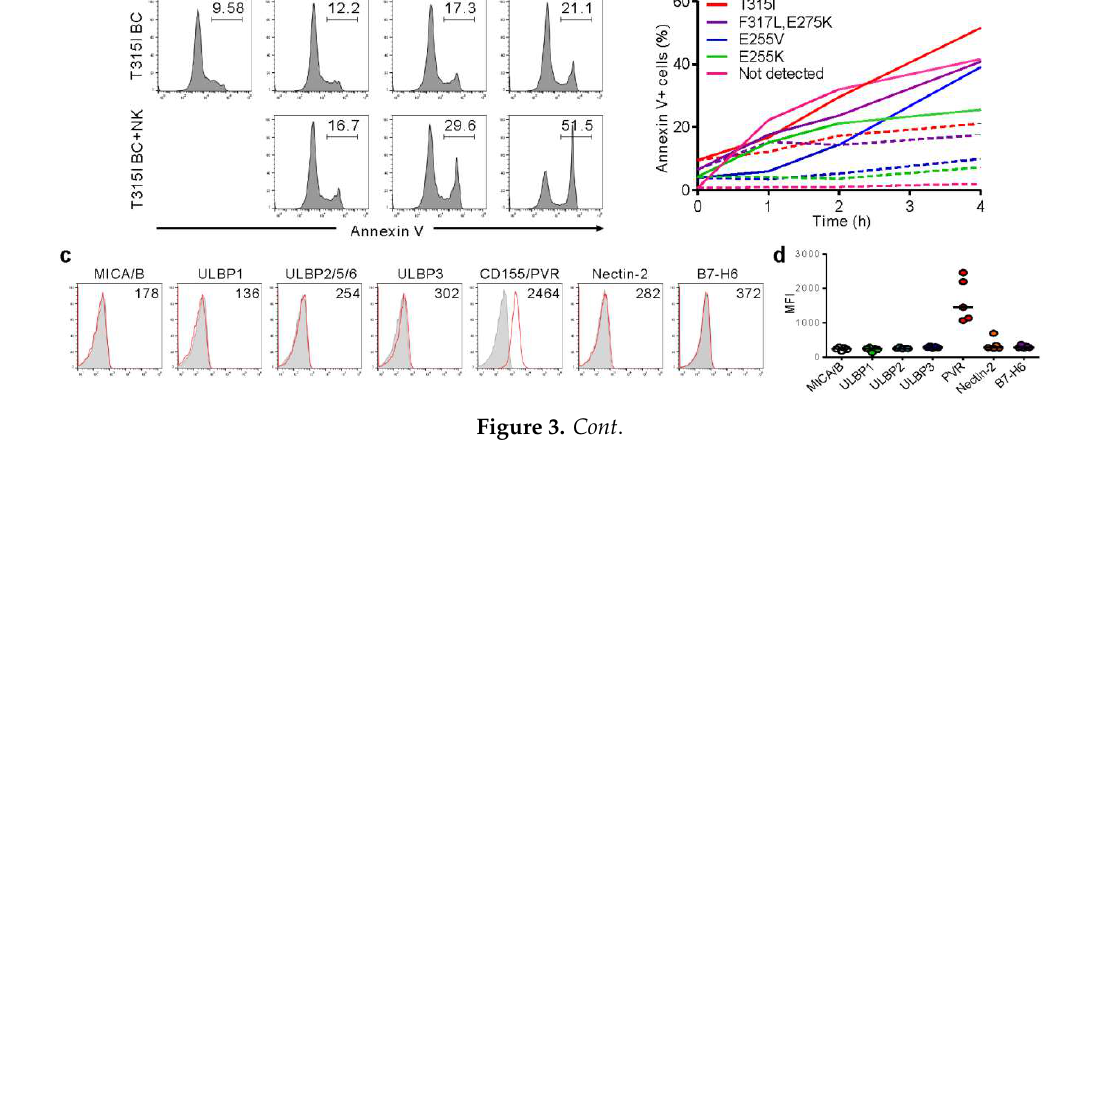
Figure 3. NK cells trigger cytolysis of primary CML-BC blasts, regardless of BCR-ABL1 mutation, in a DNAM-1-dependent manner. ( a ) Mononuclear cells (MNCs) from a CML-BC patient harboring BCR-ABL1 T315I were incubated with expanded primary NK cells for the indicated times. Apoptosis of CD34 + CML-BC cells in the absence or presence of NK cells in a 1:1 ratio was measured by annexin V-FITC and CD34-PE staining. The representative percent apoptosis of CD34 + CML-BC cells is presented as the result of two independent experiments. ( b ) MNCs from a CML-BC patient harboring different BCR-ABL1 mutations ( n = 5) were incubated with expanded primary NK cells for the indicated times. Apoptosis of CD34 + CML-BC cells in the absence (dotted line) or presence (solid line) of NK cells was measured as in ( a ). The percent apoptosis of CD34 + CML-BC cells is shown as a line graph. ( c ) Representative flow cytometric profiles showing the surface expression of NKG2D ligand (MICA/B, ULBP1, ULBP2/5/6, and ULBP3), DNAM-1 ligand (PVR and Nectin-2), or NKp30 ligand (B7-H6) on gated CD34 + CML-BC cells (red histogram). The representative mean fluorescence intensity (MFI) of each ligand in the histogram is presented as the result of two independent experiments. ( d ) The MFI of the expression of each indicated ligand on gated CD34 + CML-BC cells ( n = 5) is shown. Horizontal bars indicated the medians. ( e , f ) MNCs from a CML-BC patient were incubated with expanded primary NK cells preincubated with mAb to the indicated receptors (20 g/mL) for 2 h. Apoptosis of CD34 + CML-BC cells was measured as in ( a ). Shown are representative flow cytometry profiles ( e ) and a graph of statistical bar charts ( f ), demonstrating the percentage of